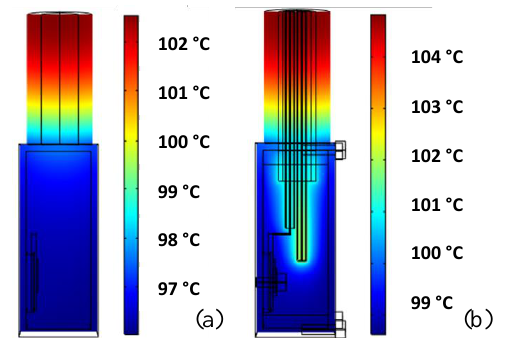
Vertical cross section of the simplified 3-D detector (a) and the complete 3-D detector (b) for a nuclear heating rate value of 0.055 W·g -1 and a fluid temperature of